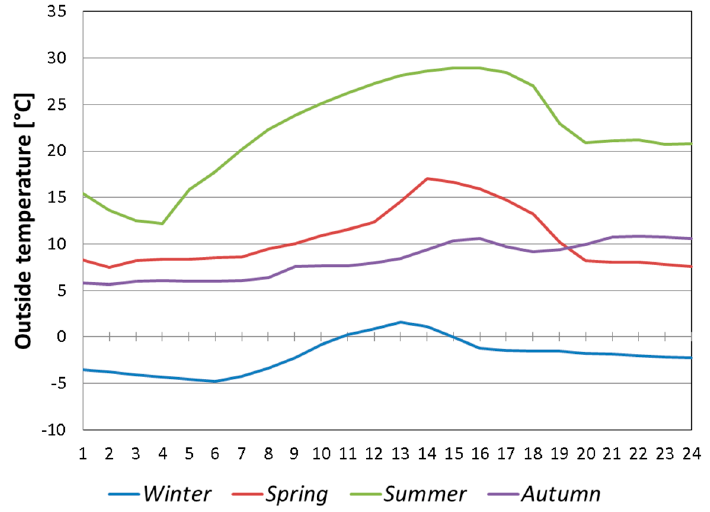
Figure 2. Outside temperature within one day in different seasons.